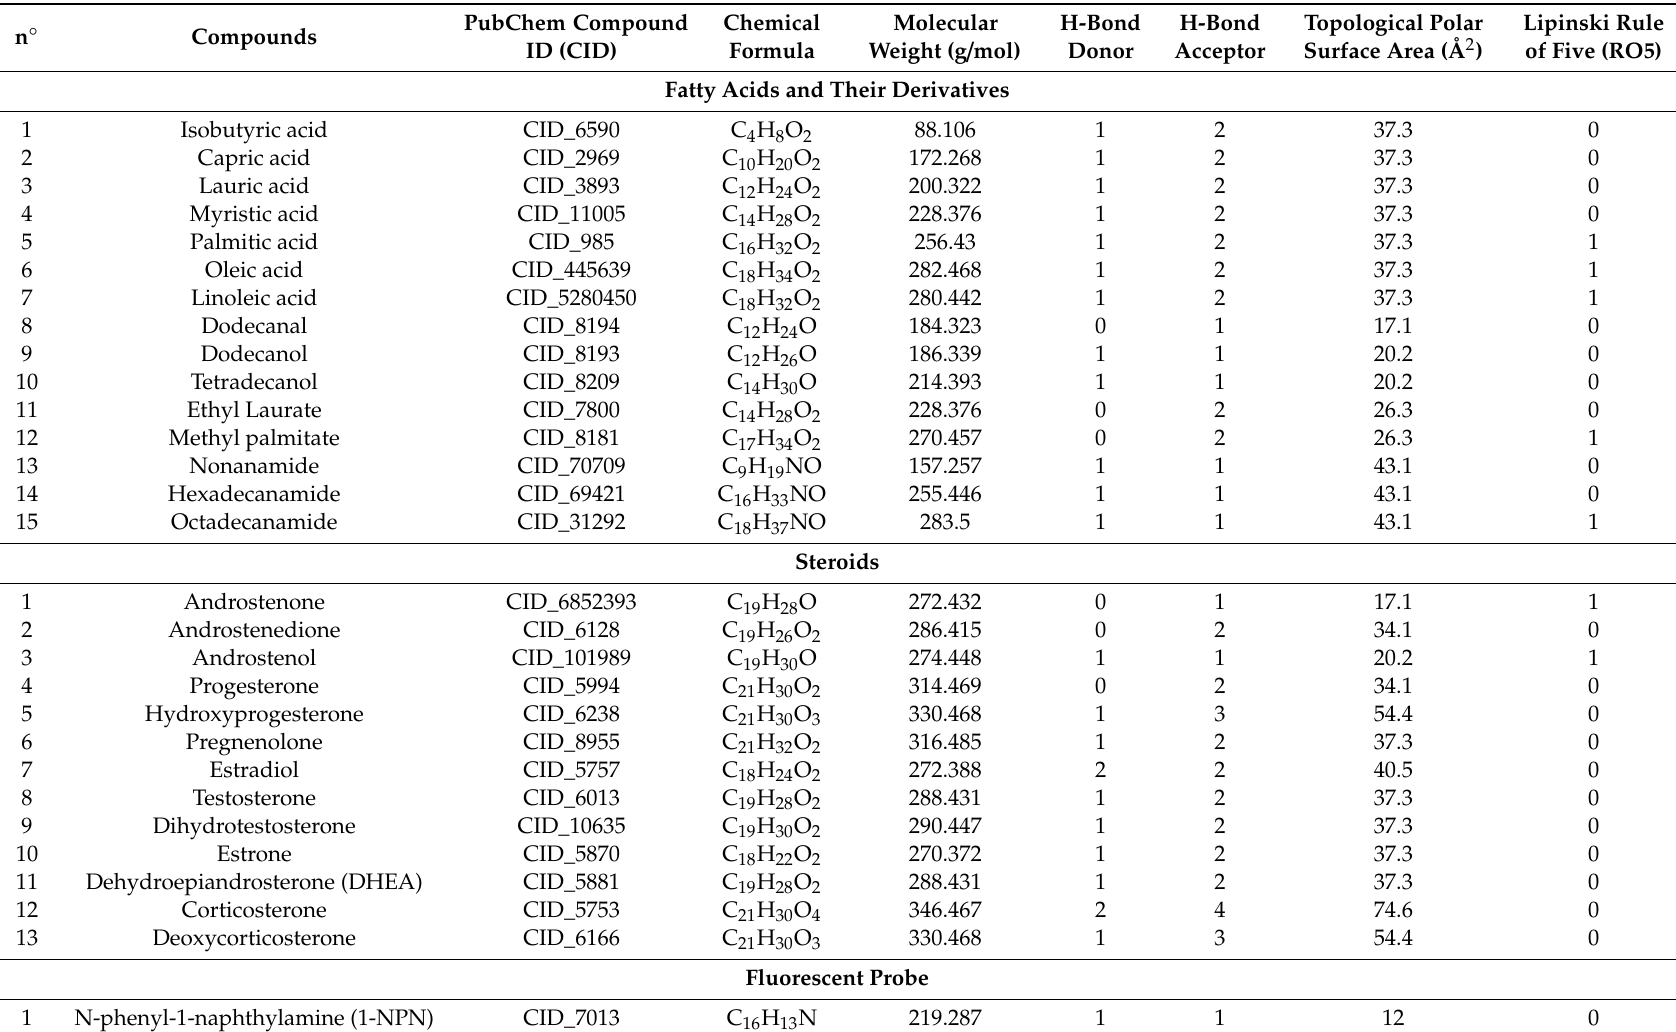
Table 3. Molecular structural properties of all putative semiochemical compounds and the fluorescent probe N-phenyl-1-naphthylamine